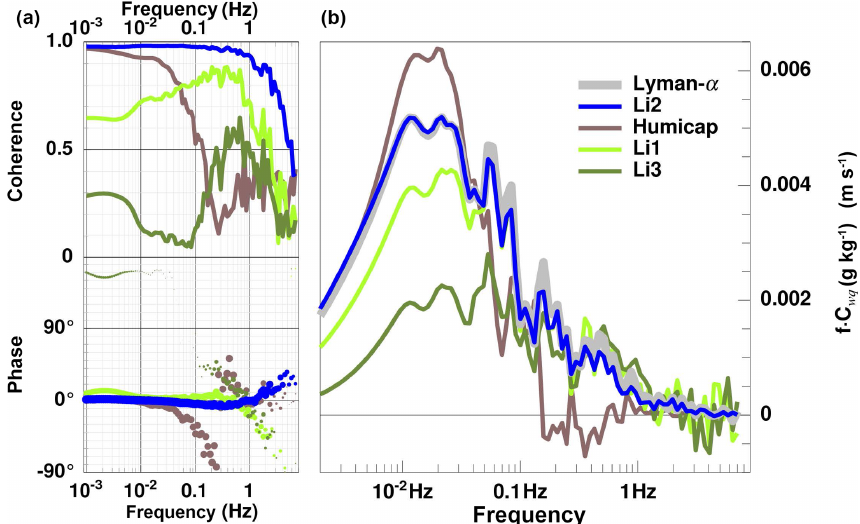
Figure 9. (a) Phase and coherence of the different LI-COR humidity sensors on the Do128 related to the Lyman-alpha sensor, with the same colour code as in Fig. 8. In the phase shift diagram, higher coherence is represented by larger dot size. (b) Cospectra of humidity from the different sensors and vertical wind speed on the Do128, multiplied by the frequency. The area under the curves is proportional to the humidity fluxes. The data are averaged over the data of the time series shaded in grey in Fig. 3.